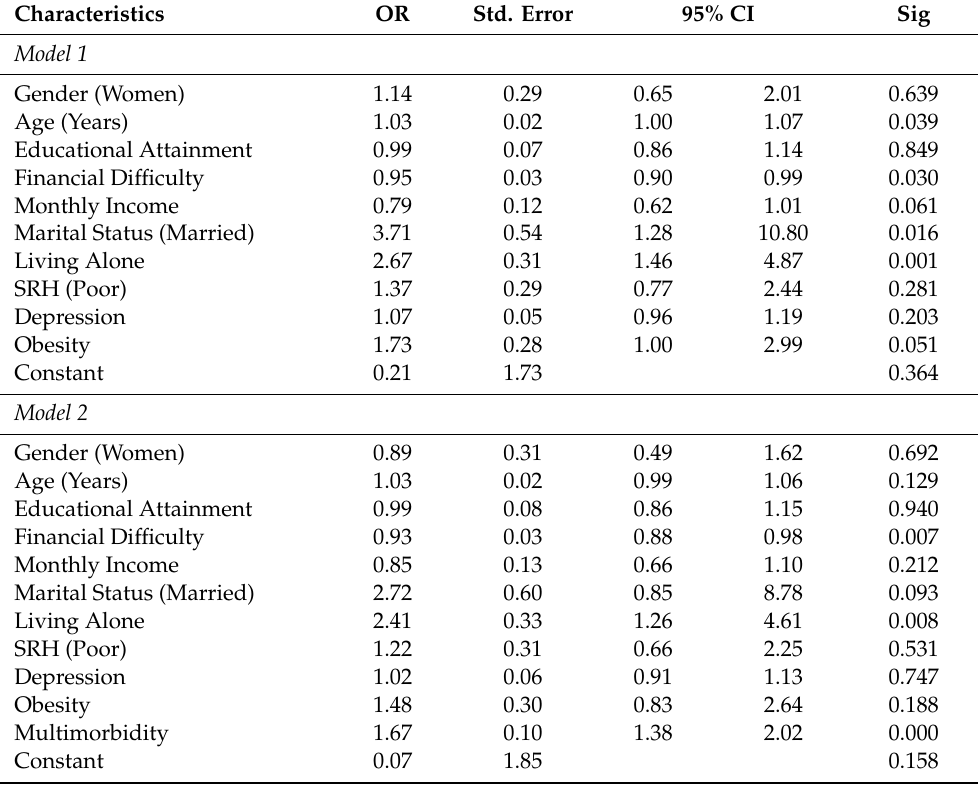
Logistic regressions on the associations between gender, obesity, multimorbidity, and polypharmacy in the pooled